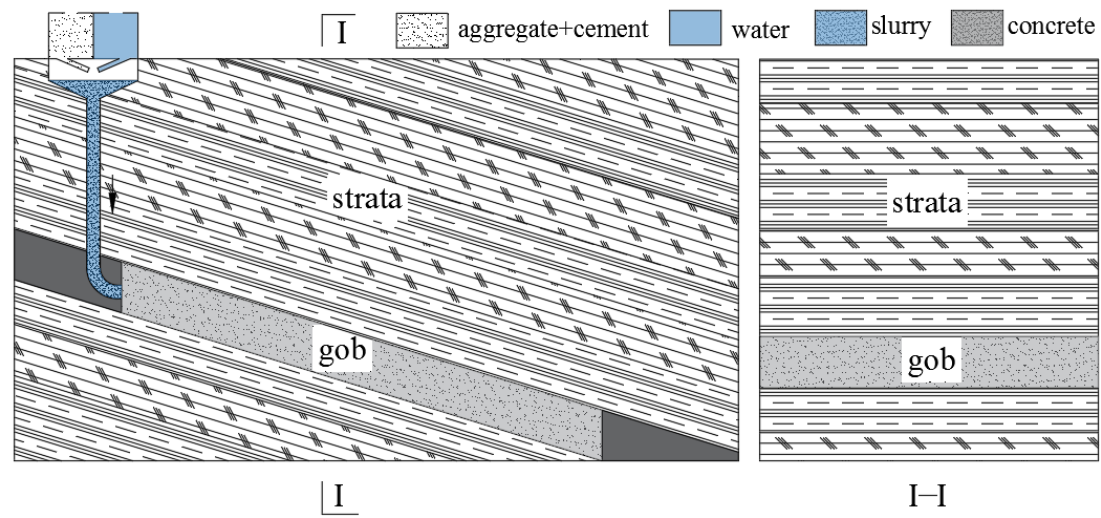
Figure 7. Cemented backfill mining system.